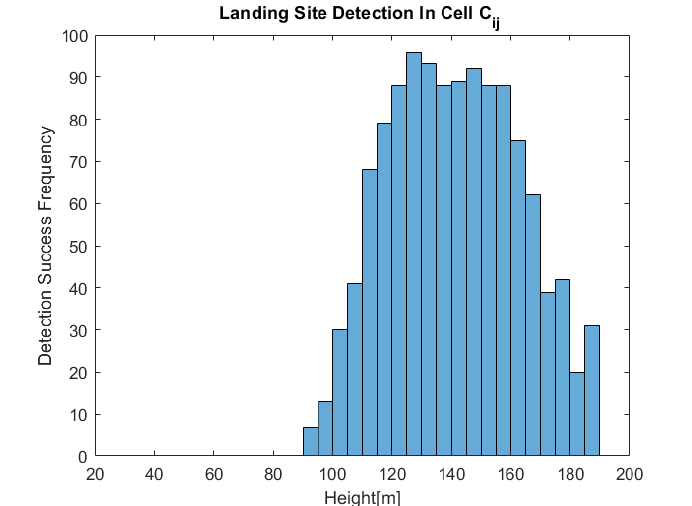
Figure 14. An altitude-based Bernoulli trial